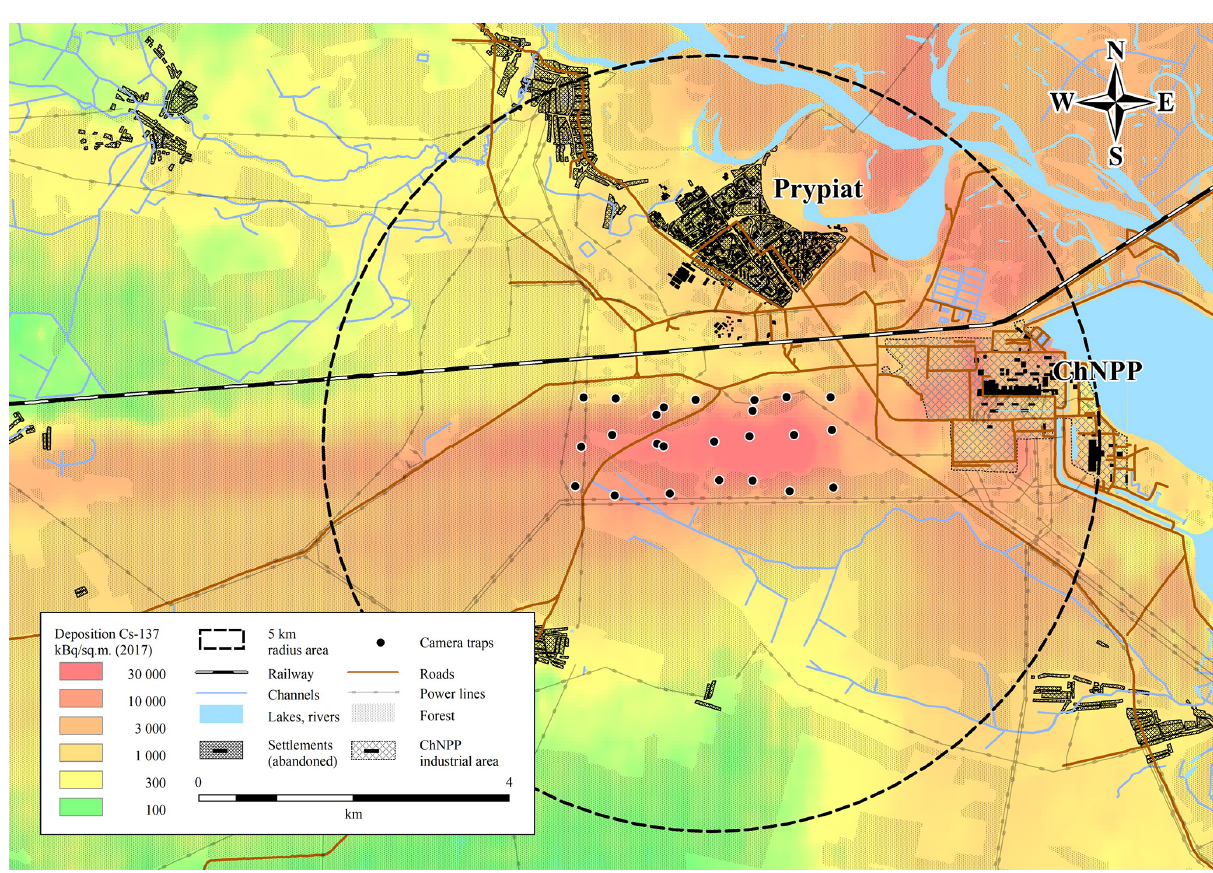
Figure 1. Map showing the location of the study cameras overlaid on a 137 Cs deposition surface (decay corrected to 2017). The large circle is the 5km radius area over which absorbed weighted dose rates were calculated. Figure produced by and published with the permission of the Chornobyl